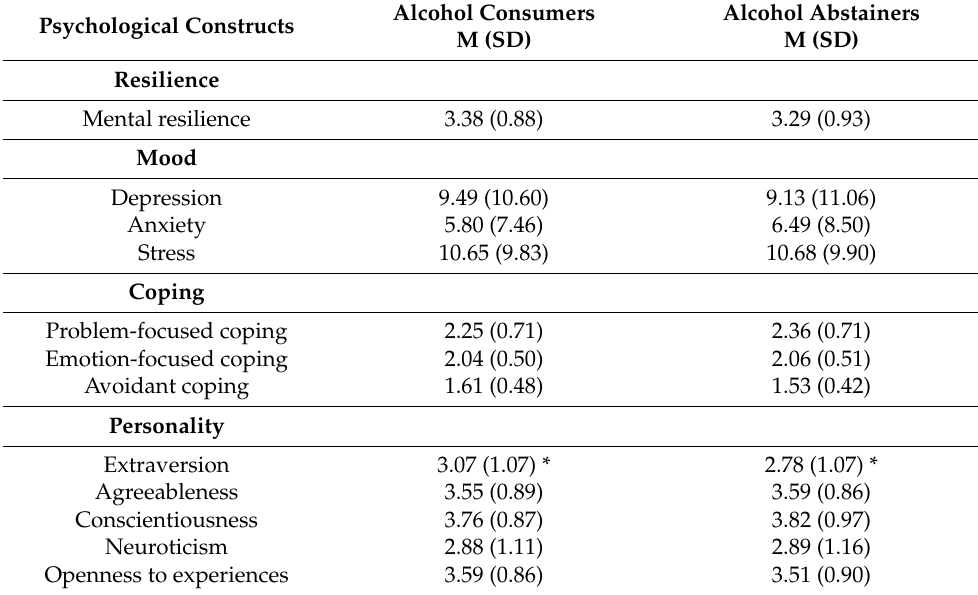
Table 2. Means and standard deviations on psychological